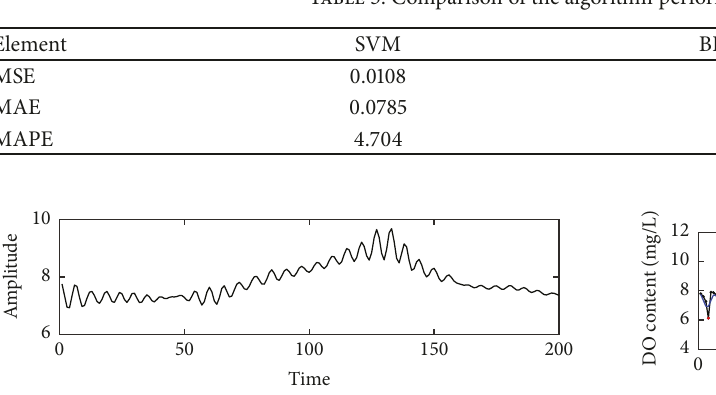
Table 5: Comparison of the algorithm performance for actual data.